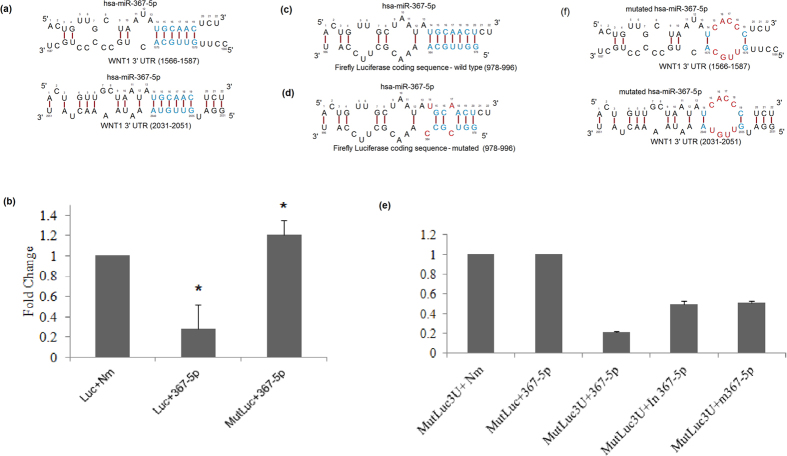
Inhibition of luciferase signal by hsa-367-5p.(a) Predicted interaction of hsa-miR-367-5p and WNT1 3′ UTR sequence. miR-367-5p has no conventional 5′ end seed matched site in WNT1 3′ UTR, but it contains two non-conventional 3′ end matched binding site in the positions 1566-1575 and 2035-2040 in the WNT1 mRNA 3′ UTR sequence. (b) MCF-7 cells were co-transfected with mimic of hsa-367-5p miRNA or non-specific control RNA oligo (Nm) and plasmid DNA encoding wild-type luciferase gene or mutant luciferase gene. Note that wild-type, not the mutant, luciferase gene was inhibited by hsa-367-3p miRNA. The luminescence signal in wild-type luciferase was reduced by approximately 71%. (c) Predicted interaction of hsa-miR-367-5p and luciferase coding sequence. miR-367-5p has no conventional 5′ end seed matched site in luciferase gene, but it contains one non-conventional 3′ end matched binding site in the 978–984 region in the luciferase gene coding sequence. (d) The predicted binding site of hsa-miR-367-5p on firefly luciferase coding sequence is mutated (GGUUGCA- > GGUCGC) so that hsa-miR-367-5p could no longer bind and repress luciferase gene. (e) MCF-7 cells were co-transfected with mimic hsa-miR-367-5p miRNA or inhibitor of hsa-miR-367-5p or mutant hsa-miR-367-5p or non-specific control RNA oligo and plasmid DNA encoding mutant luciferase gene tagged with 3′-UTR of WNT1. The luminescence signal was reduced approximately 79% in case of co-transfection of mimic has-miR-367-5p. Note that luciferase signal was reduced in the presence of hsa-367-5p miRNA and that ~30% luciferase was recovered in presence of has-miR-367-5p inhibitor or mutant hsa-miR-367-5p. *p < 0.05, Nm vs hsa-miR-367-5p. (f) hsa-miR-367-5p is mutated in its predicted binding site in its 3′ end i.e. base 14–19 (UGCAAC- > UCACCC) so that the binding of mutant hsa-miR-367-5p 3′ end with the two sites in WNT1 3′ UTR is perturbed.